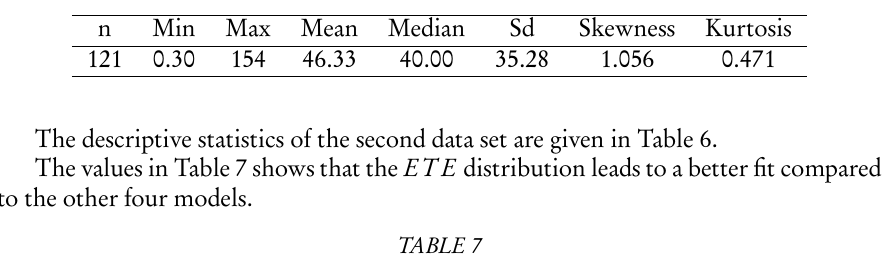
Descriptive statistics of second data set.